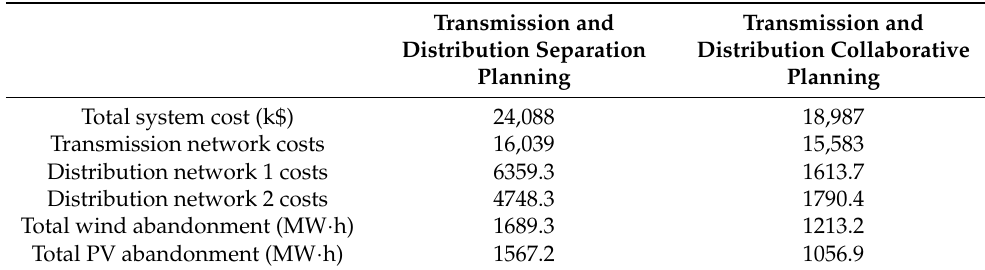
Table 7. Comparison of transmission and distribution collaborative planning/transmission and distribution separation planning